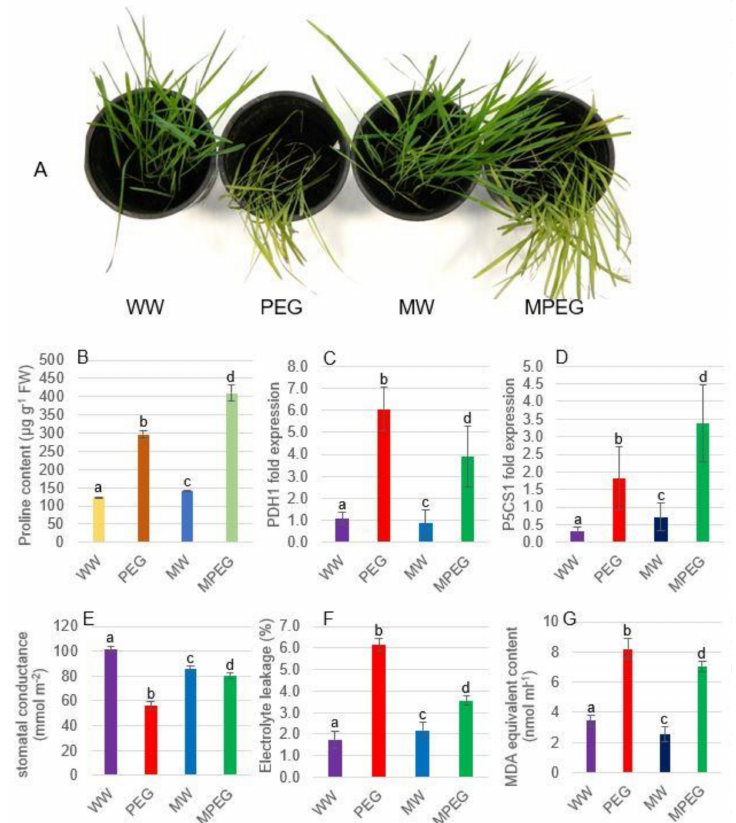
Figure 2. ( A ) E ff ect of pretreatment with melatonin on the morphological di ff erences between the four treatments in oat plants. ( B ) Proline content, ( C ) PDH1 gene expression, ( D ) P5CS1 gene expression, ( E ) Stomatal conductance, ( F ) Electrolyte leakage, and ( G ) MDA equivalent content estimation. WW, well-watered; PEG, PEG-treated oat plants; MW, Melatonin-treated well-watered oat plants; MPEG, Melatonin-treated oat plants subjected to PEG stress. Di ff erent letters in each row indicate significant di ff erences ( p ≤ 0.05 ) between the treatments after performing Tukey’s test ( n =